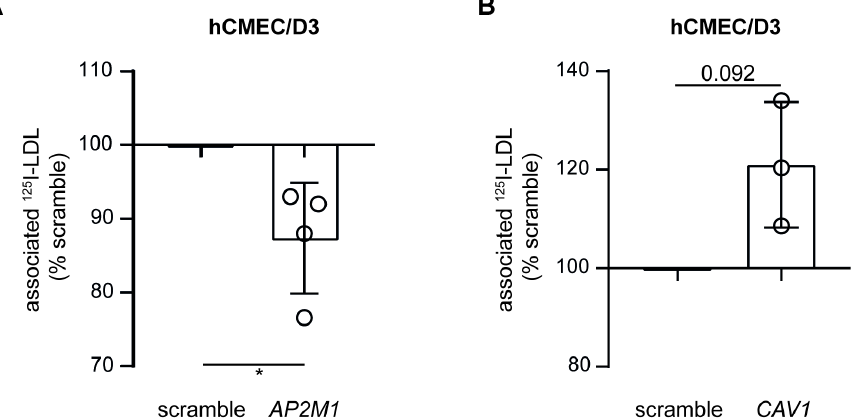
Figure 6. Knocking down AP2M1 but not caveolin reduces LDL association to hCMEC/D3. Seventy- two hours after knocking down AP2M1 ( A ) or CAV1 ( B ) using siRNA, I 125 -LDL association was measured as above. Points in graphs represent individual experiments (biological replicates, n = 3–4), bars represent the mean and error bars ± SD, * p =